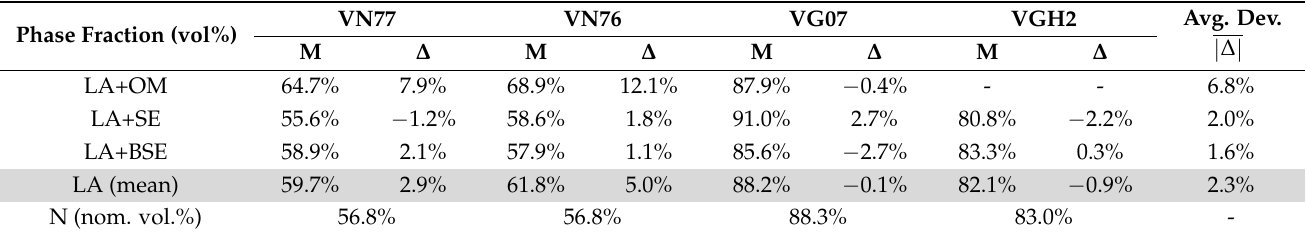
Table 8. Phase fractions (vol%) of WC grains obtained by the LA.